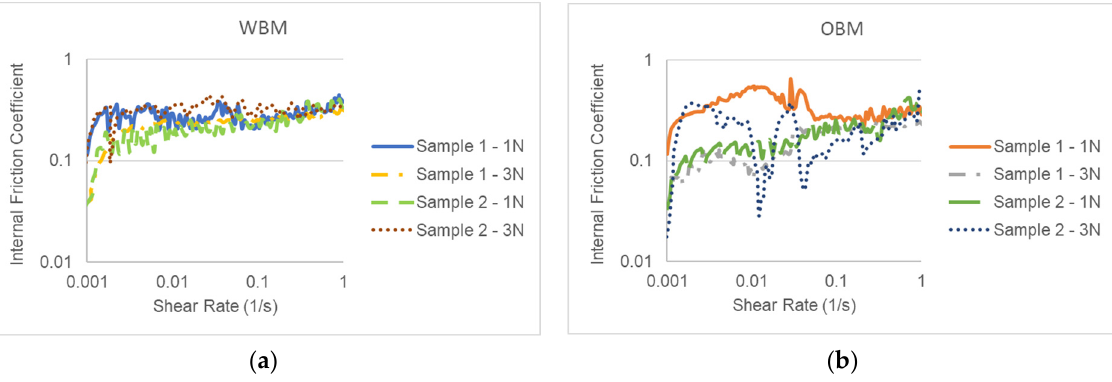
Figure 6. Cuttings bed internal friction coefficient under constant normal force in ( a ) the WBM and ( b ) OBM. The internal friction coefficient of the cutting particles wetted with the WBM is dis- tributed more uniformly around a median of 0.27, with a variance of 0.008 and a mean of 0.24, as shown in Figure 7. The particles wetted with OBM presented a wider internal friction coefficient spectrum and a median of 0.22, a higher variance of 0.018 and higher mean of 0.28.